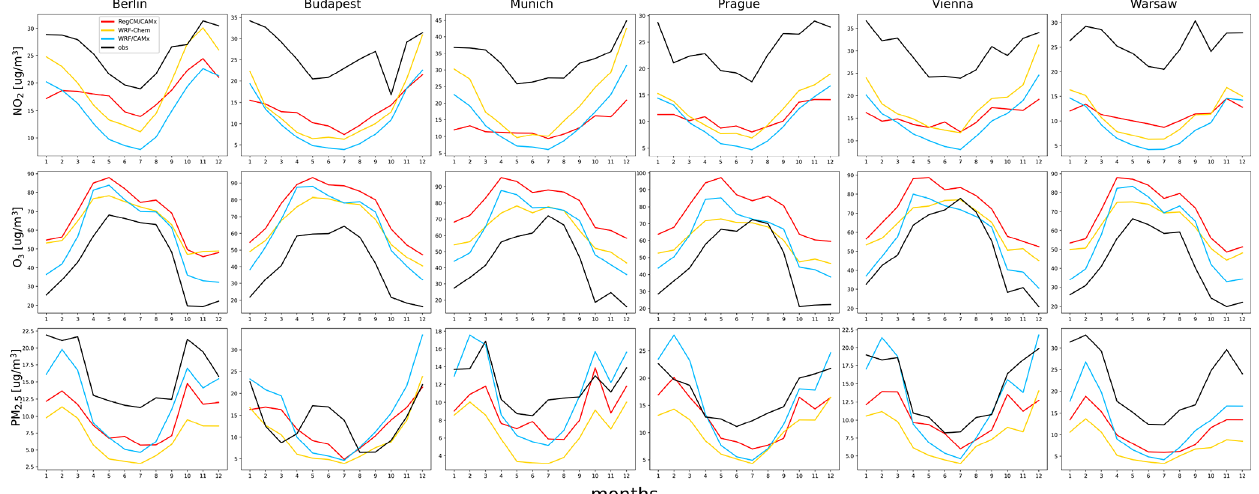
Figure 3. Comparison of the modeled average annual variation in monthly means with observations for the six selected cities and three pollutants: NO 2 , O 3 and PM 2 . 5 (in µgm − 3 ). The black line means observations, and red, yellow and sky blue stand for RegCM/CAMx, WRF-Chem and WRF/CAMx